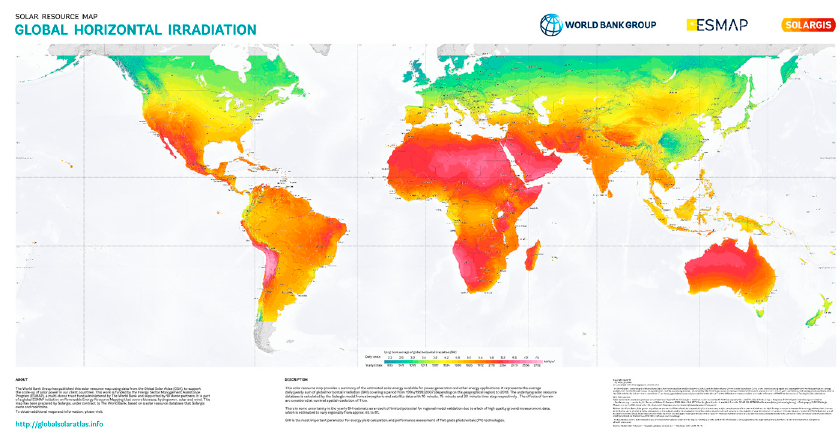
Figure 2. World GHI map Figure 2. world GHI map [21]. Figure 2. world GHI map [21].